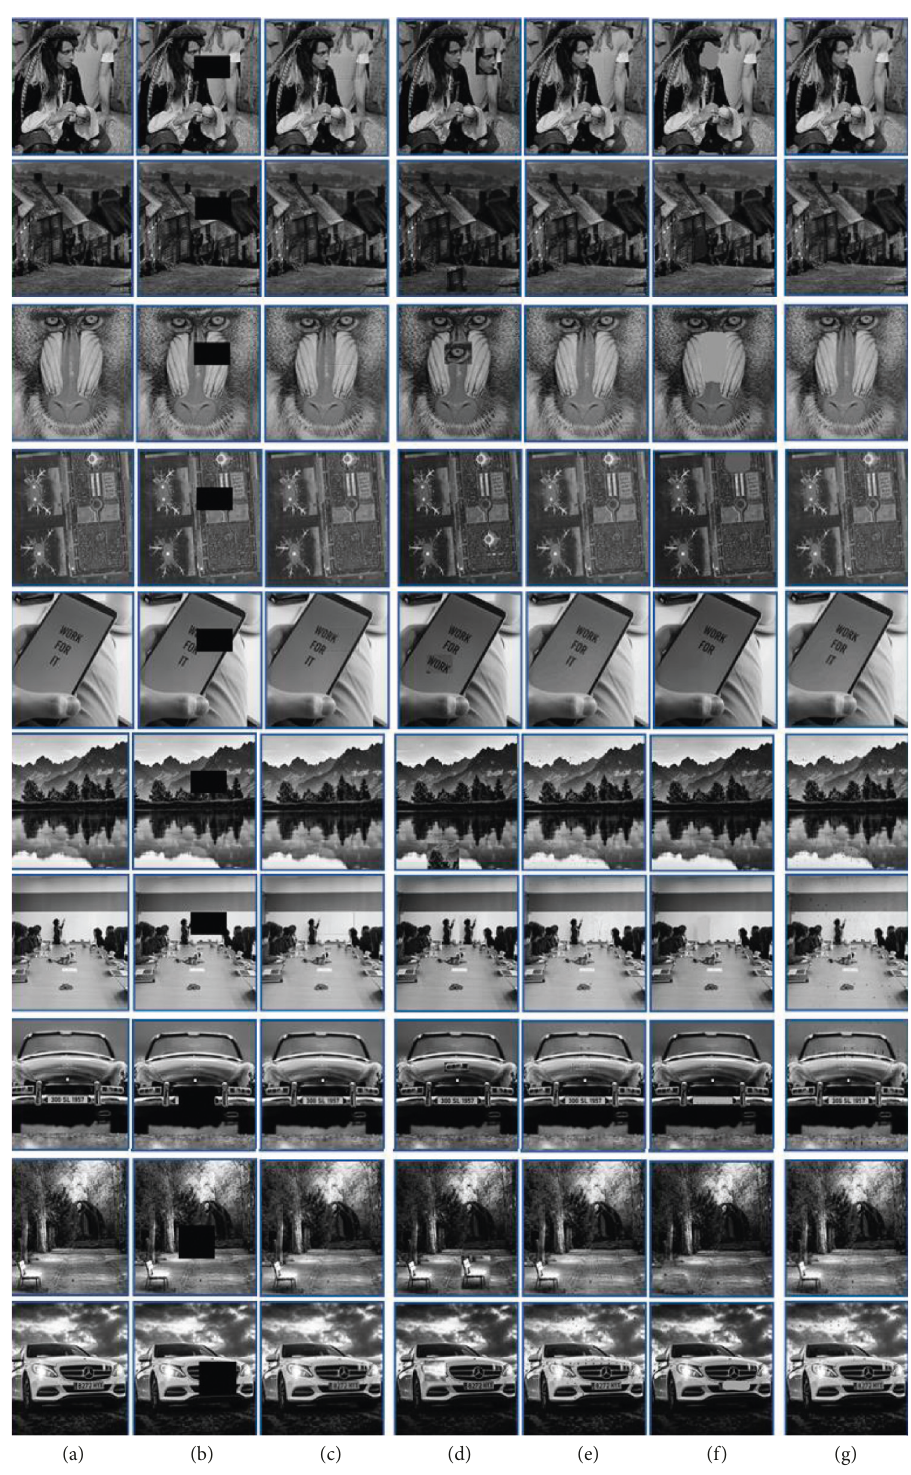
Figure 9: Recovery after different